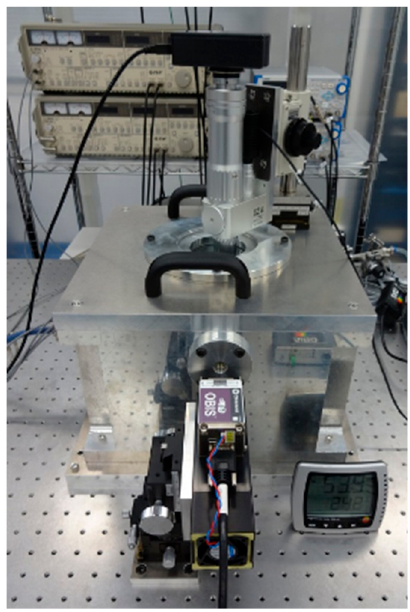
Figure 8. Photograph of measurement system in vacuum vessel.